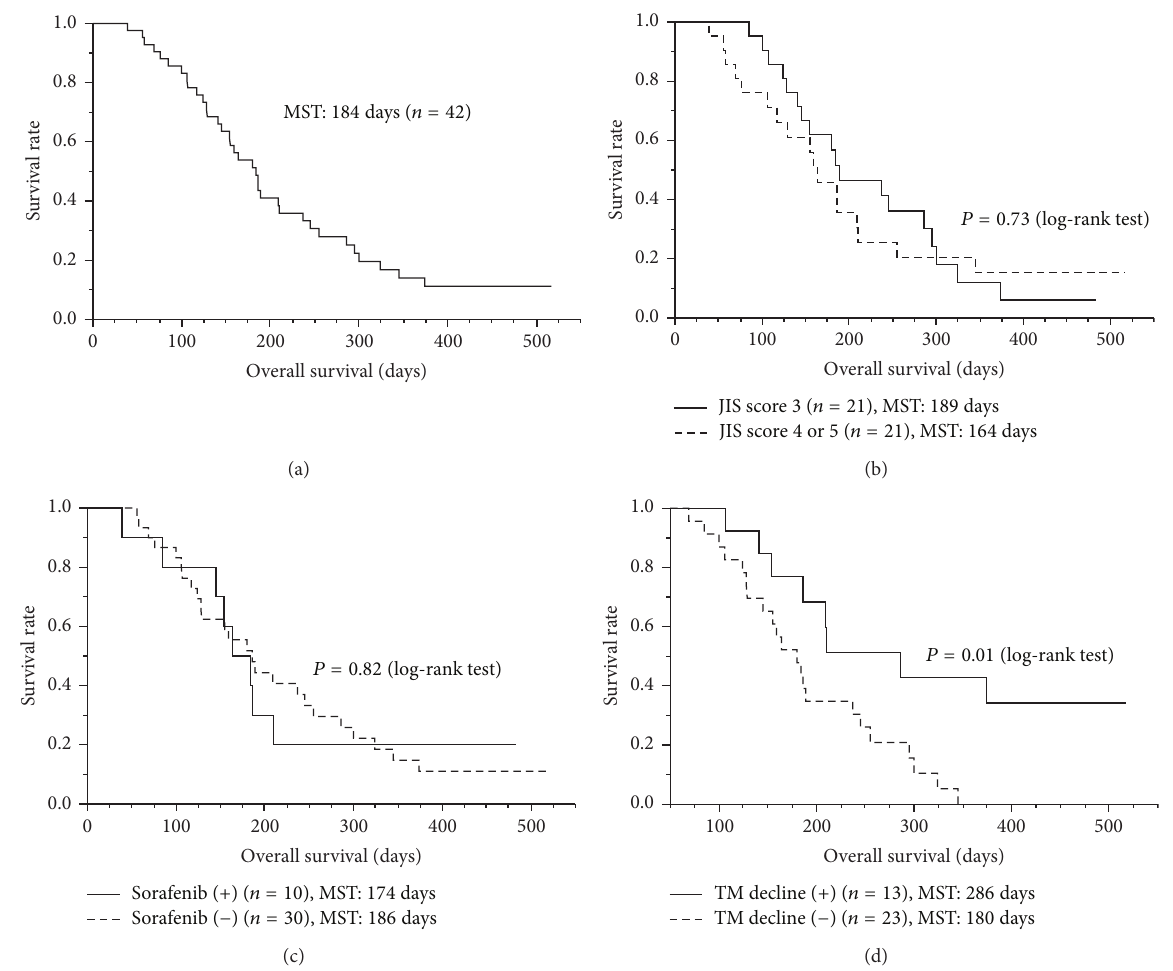
Figure 1: Survival analysis. The survival analysis was performed with the Kaplan-Meier method, and a comparison of the survival curves was performed with the log-rank test. (a) The median survival time (MST) from the first vaccination of PPV was 184 days in 42 patients. (b) The patients with a JIS score of 3 (MST, 189 days) did not show significantly different survival, compared to those with a JIS score of 4 or 5 (MST, 164 days) ( 𝑃 = 0.73 ). (c) Combination therapy with sorafenib did not affect OS ( 𝑃 = 0.82 ). (d) Patients with decreased TM (tumor markers), AFP, or DCP, after vaccination (MST, 286 days) showed longer survival than those without it (MST, 180 days) ( 𝑃 = 0.01 ).